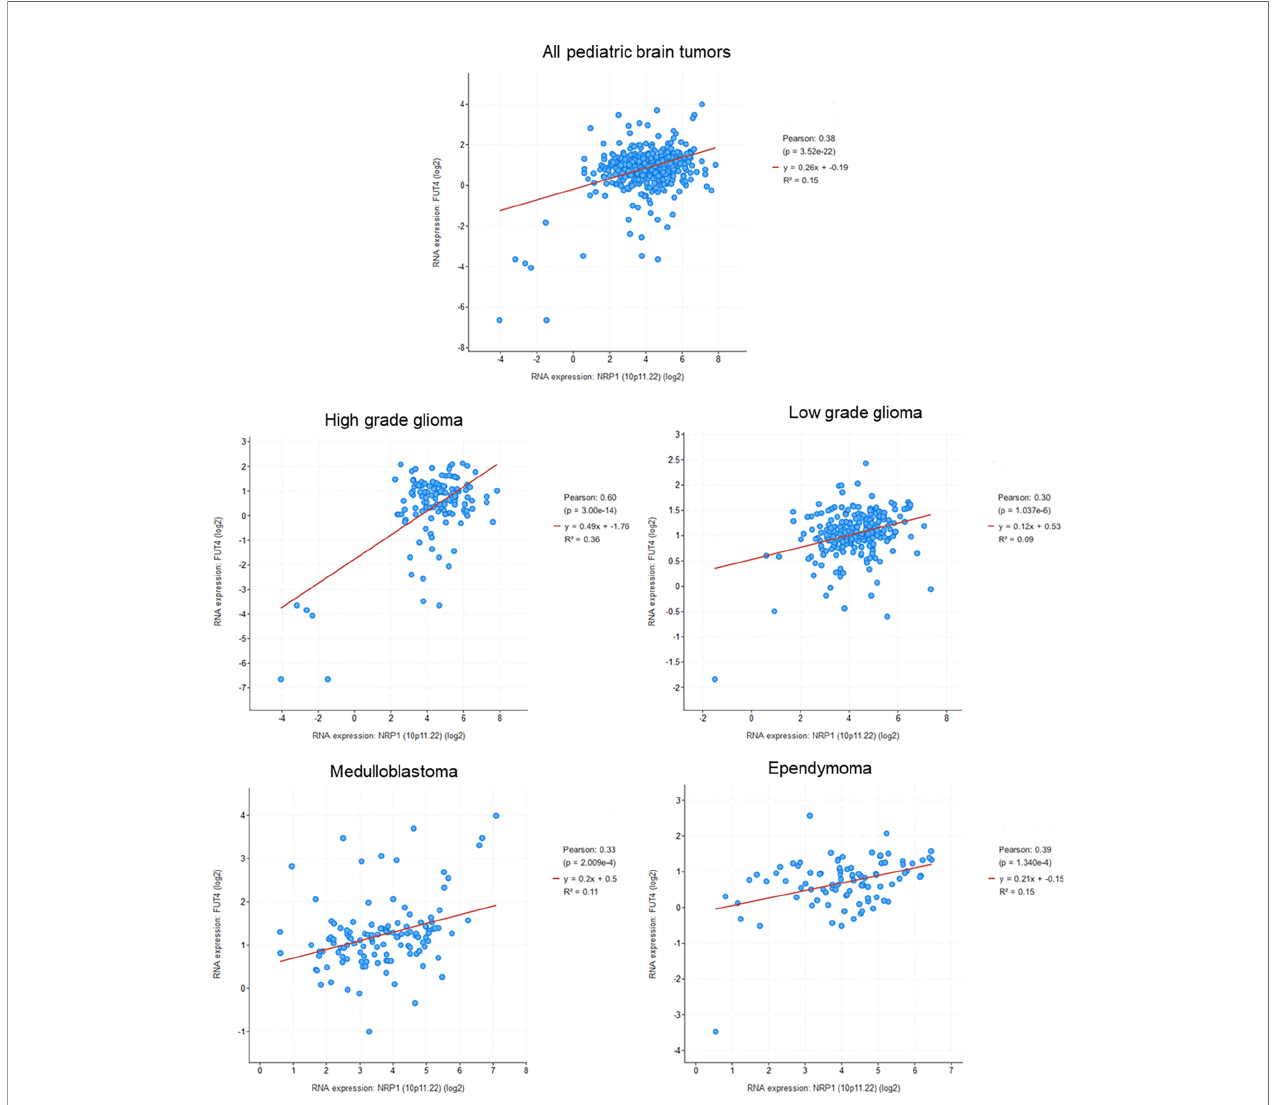
FIGURE 3 | Correlation between NRP1 and CD15 (FUT4) expression in pediatric brain tumors (Genomic characterization has obtained with cBioPortal provided by the Children ’ s Brain Tumor Tissue Consortium Database; Pediatric High Grade Gliomas: 133 samples; Pediatric Low Grade Gliomas: 261 samples; Medulloblastoma: 130 samples; Ependymomal Tumor: 97 samples). Pearson's correlation coef fi cient and corresponding p value were given for each tumor